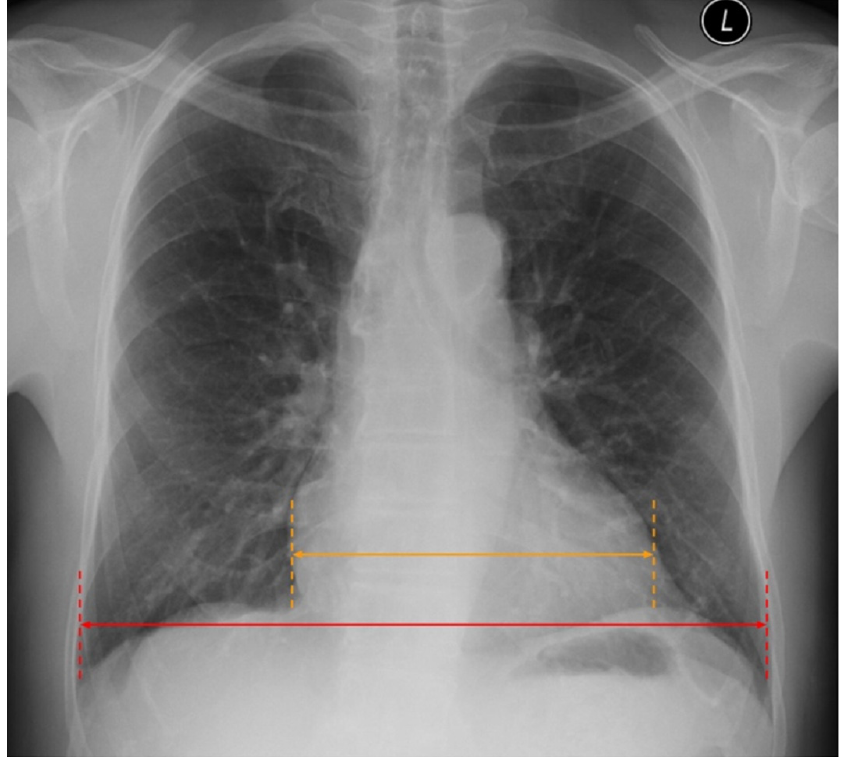
Figure 4. Increased cardiac thoracic ratio > 0.5 in CXR. Figure obtained with permission from the 2nd Department of Radiology, Medical University of Warsaw.